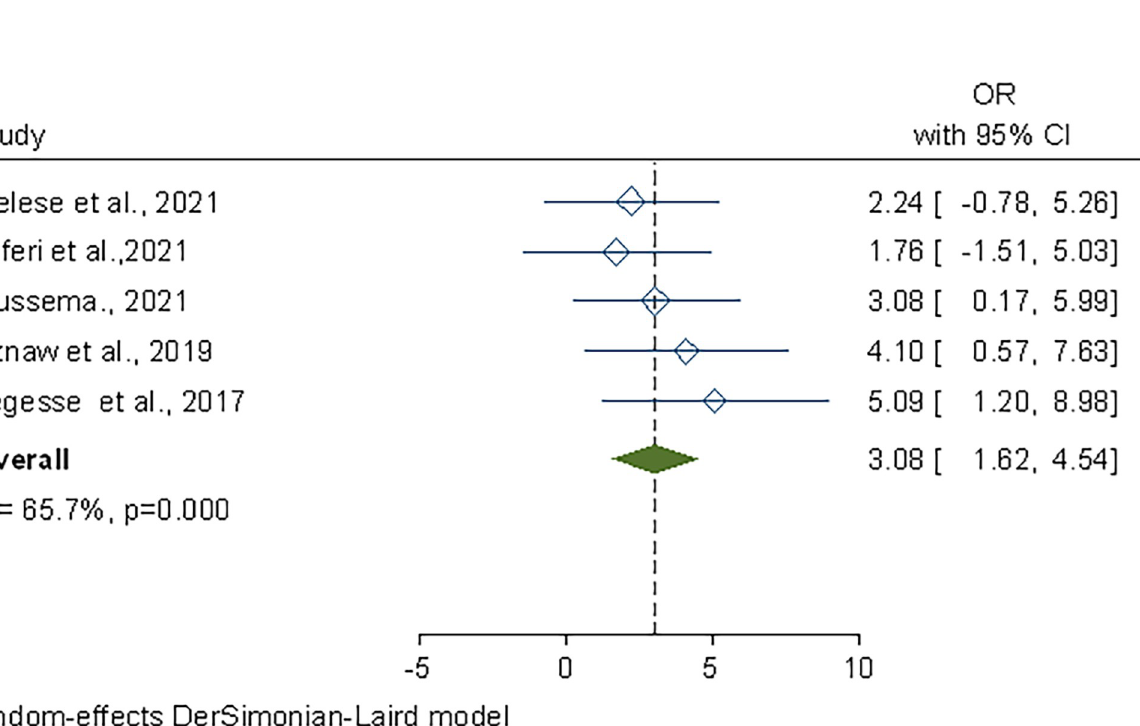
PLOS ONE | https://doi.org/10.1371/journal.pone.0268918 May 27, 2022 15 /